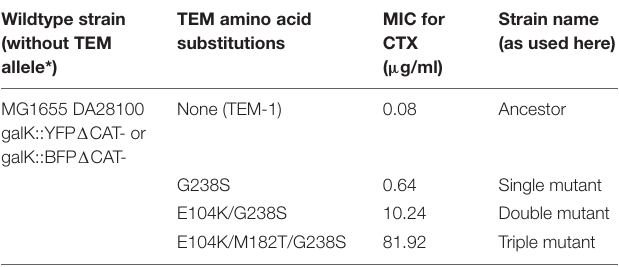
TABLE 1 | Overview of the used strains. Wildtype strain (without